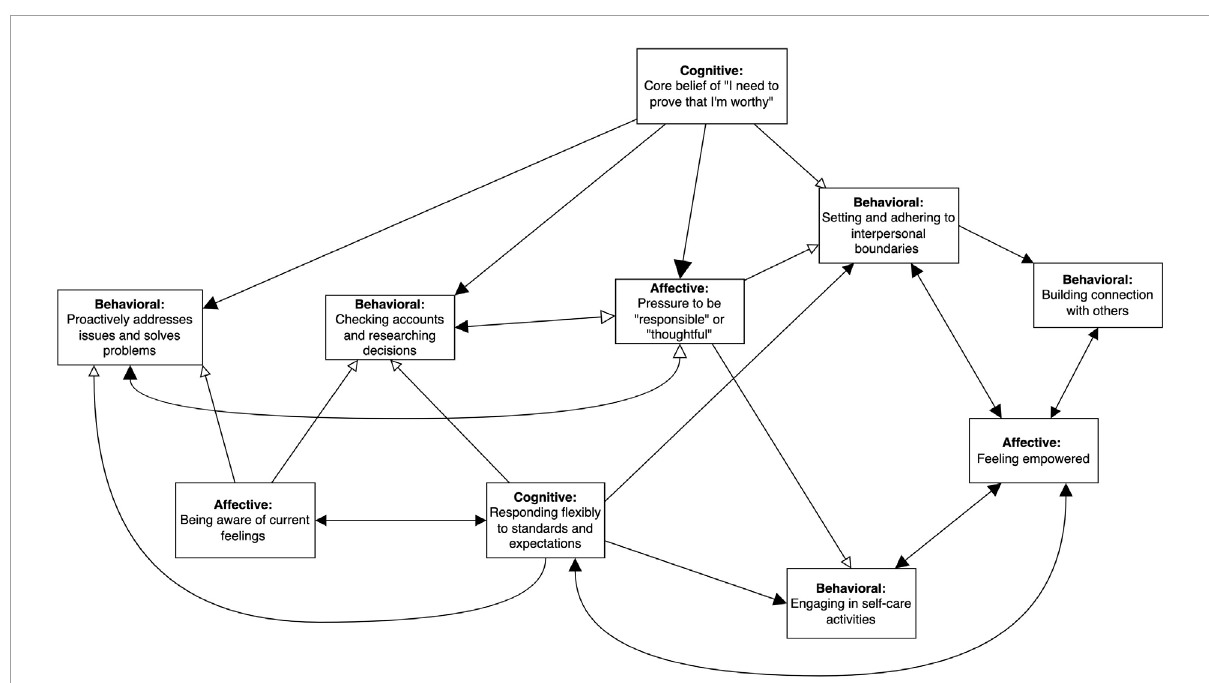
FIGURE5 Subnetwork with adaptive nodes added after start of treatment. EEMM dimensions represented by each node are bolded. Size of the arrowheads indicates hypothesized strength of the relationship (bigger arrowheads = stronger correlation), and opacity reflects direction of the relationship (opaque = positive/excitatory, transparent = negative/inhibitory). Right-angled rectangles reflect manipulable variables and rounded rectangles indicate immutable moderators (e.g., historical events). Reinforcing valence of “feeling empowered” is indicated by double-headed excitatory arrows with “responding flexibly to standards and expectations,” “setting and adhering to interpersonal boundaries,” “building connection with others,” and “engaging in self-care